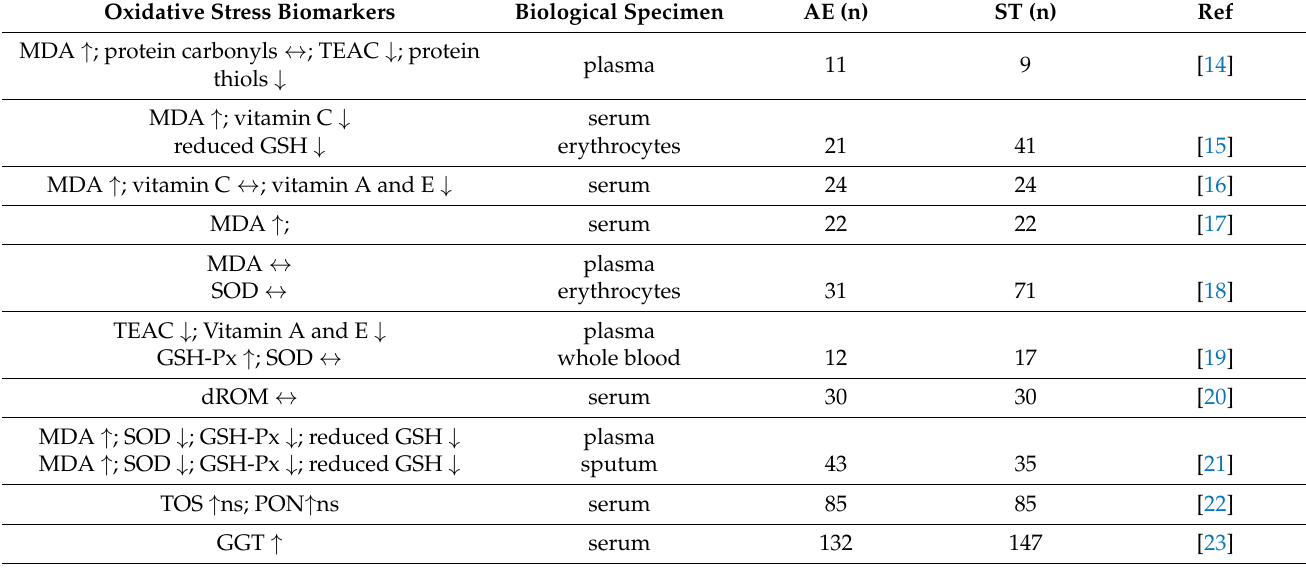
Table 1. Oxidative stress biomarkers in exacerbated COPD patients (AE) compared to stable (ST). Oxidative Stress